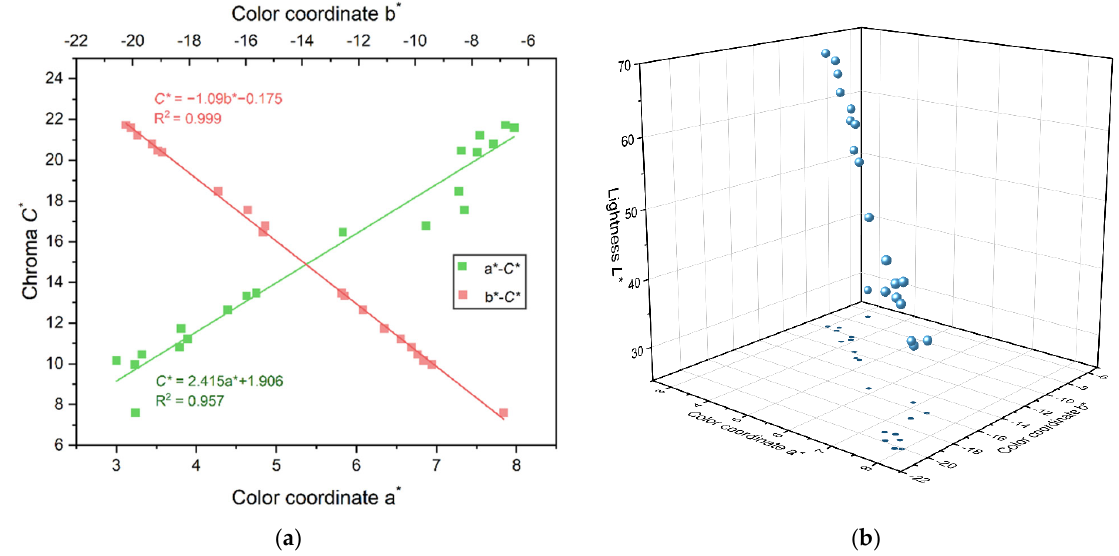
Figure 3. ( a ) Relationship between color coordinates a* and b* and the chroma C* . ( b ) A total of 20 iolite blue plots in the CIE 1976 L*a*b* uniform color space.